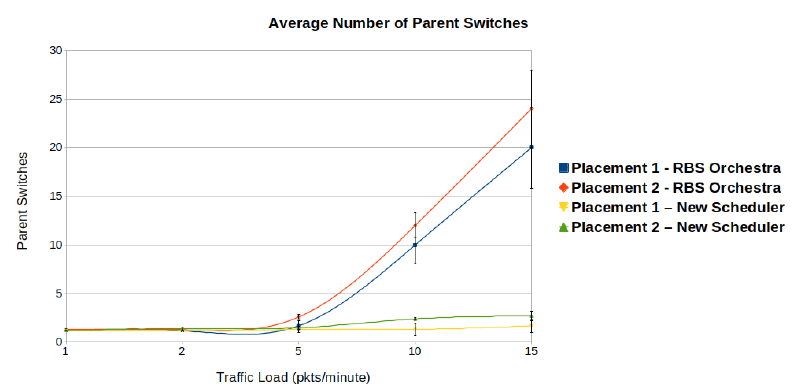
Figure 15. We observe that when it comes to stability, the new scheduler performs better than Orchestra, in high traffic